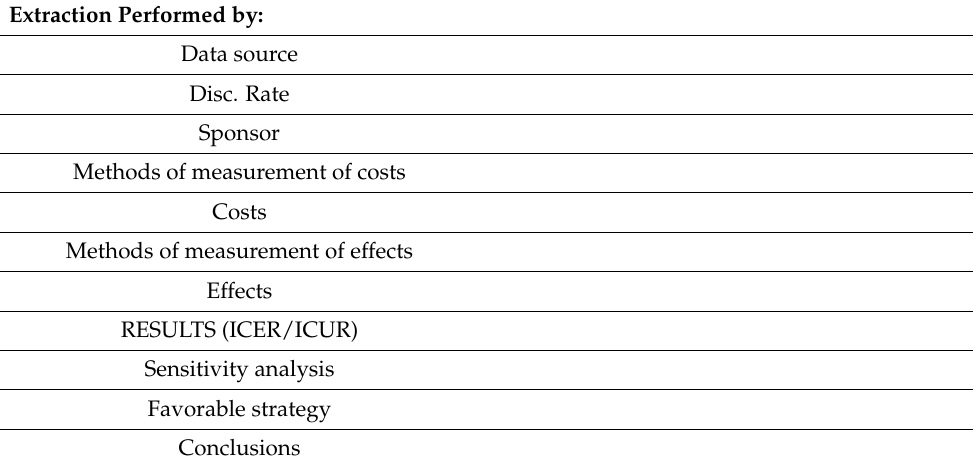
Table A2. Cont. Extraction Performed by: